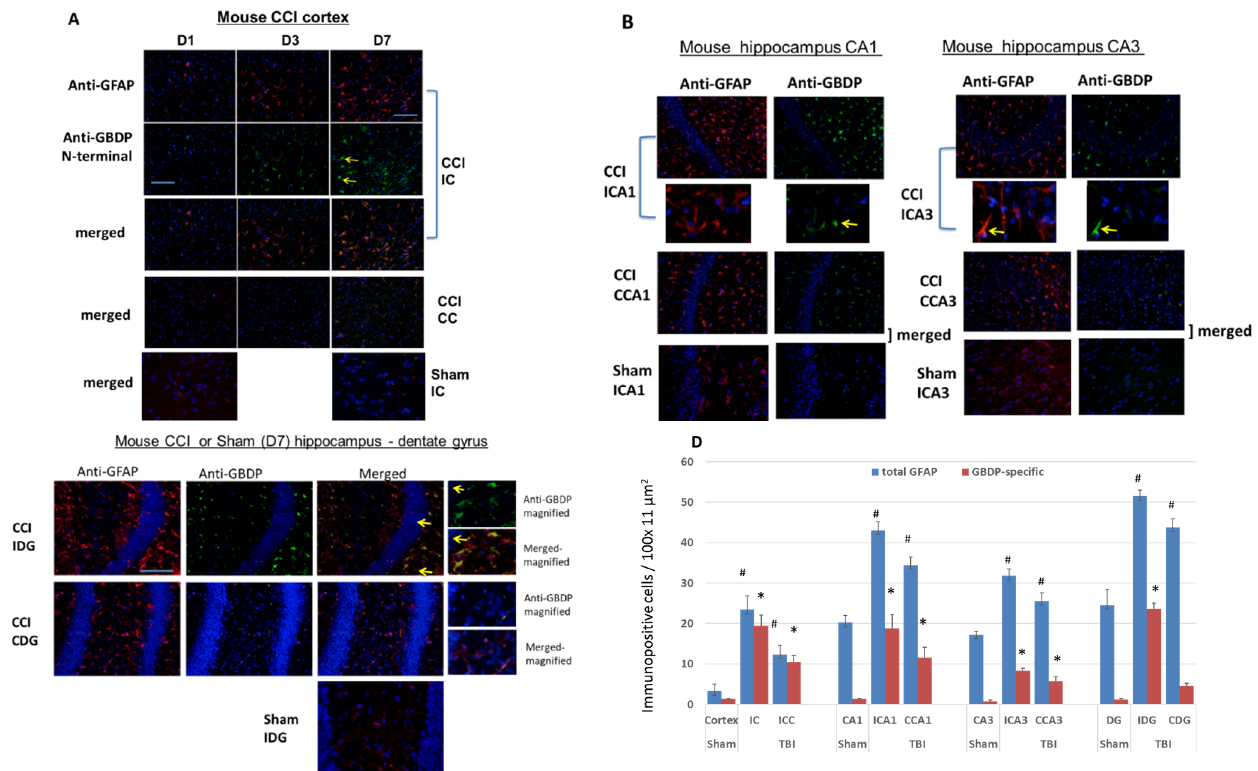
Figure 7. Immunohistochemical staining with an injured mouse brain with total GFAP and anti- GBDP N-terminal specific antibodies. CCI mouse. Red: anti-GFAP, green: anti-GBDP. Shown are injured cortex ( A ), injured hippocampus [CA1 and CA3 cell layers ( B ) and dentate gyrus ( C )] with total GFAP and anti-GBDP N-terminal specific antibody. 7 days post-CCI mouse brains are examined. Red: anti-GFAP, green: anti-GBDP. ICA1, ipsilateral CA1, CCA1, contralateral CA1, ICA3, Ipsilateral CA3, CCA3, contralateral CA3. Yellow arrows indicated GBDP Antibody labeled cells. ( D ) quantification of total GFA or GBDP positive cells from control rats (naïve) or rats 7 days after CCI, ipsilateral and contralateral cortex, and hippocampus (CA1, CA3, and dentate gyrus (DG)) were used. Shown are mean ± SEM (n = 4). * p < 0.05, # p < 0.05 when compared to control. (student’s t -test).